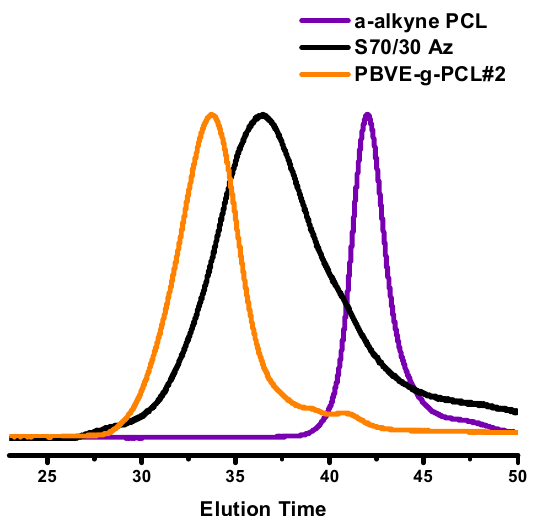
Figure 5. Monitoring the synthesis of sample PBVE– g –PCL#2 via the grafting “onto” methodology by IR spectroscopy.